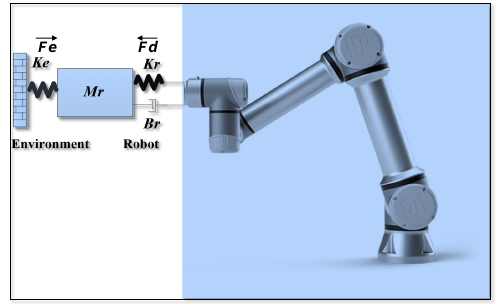
Figure 1. Contact force